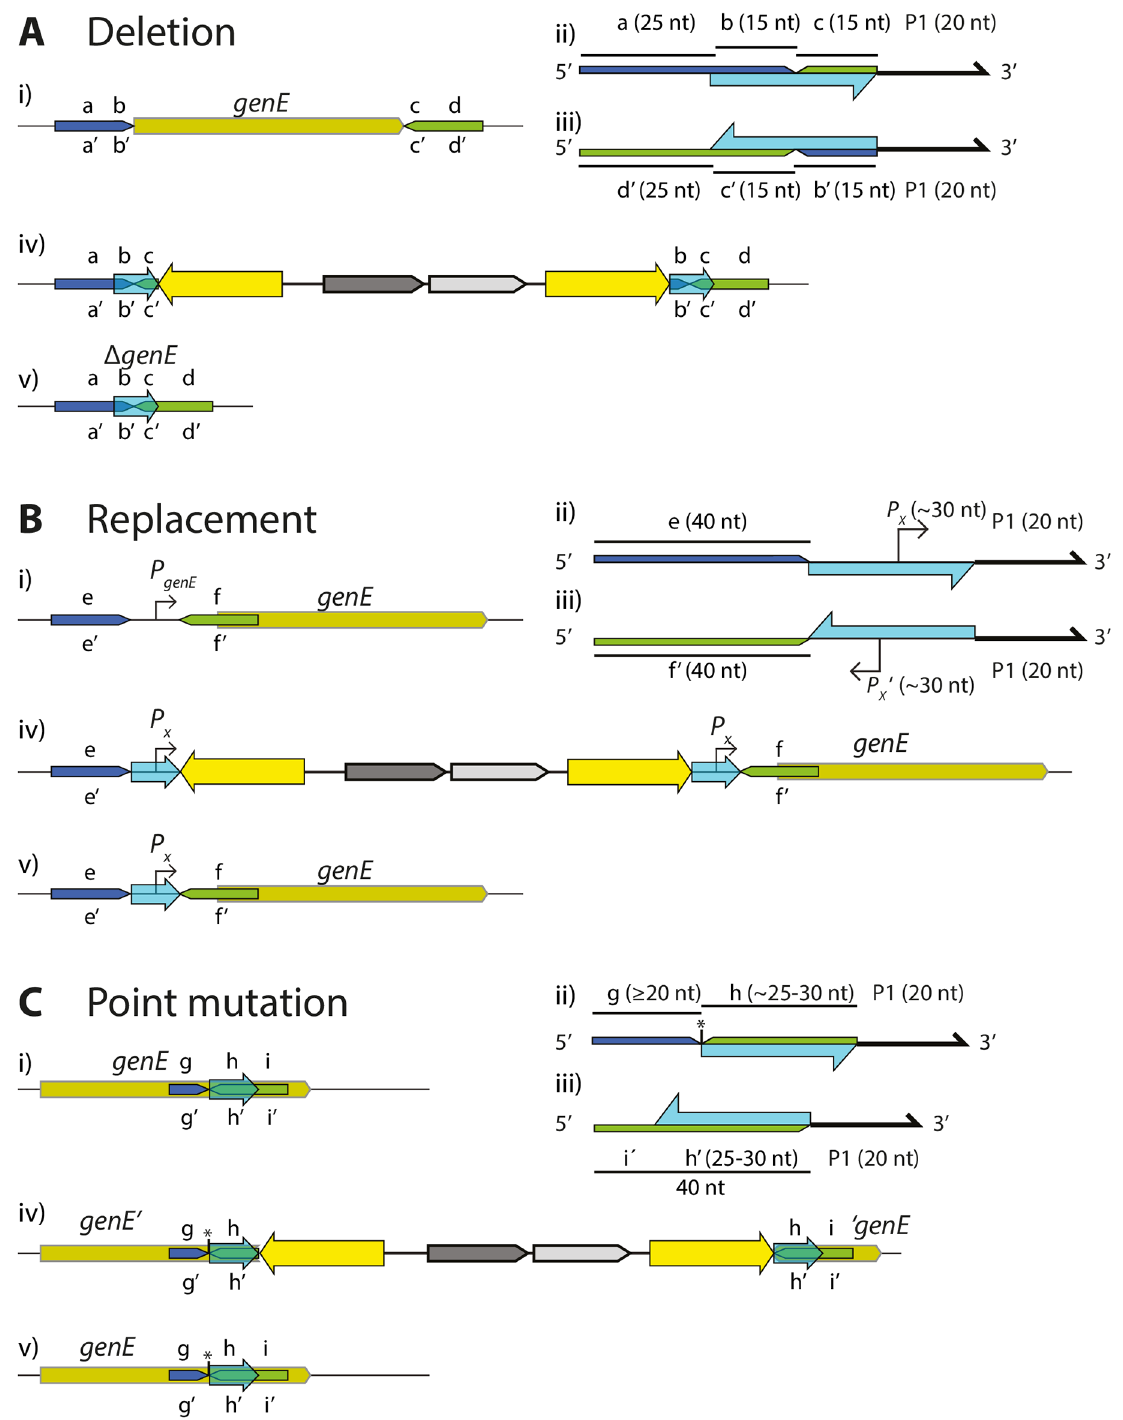
Fig 3. Primer design for DIRex. Light blue arrows indicatethe location and orientation of DR sequencesbetweenwhich recombination is expectedto occur. Sequence segments on the upper strand are labeledwith lower case letters a–i, and on the lower strand the complementary sequencesare labeleda’–i’. (A) Using DIRex for deletinga gene. (A, i) Two 40 nt regionsof recombineeringhomology(a-b, dark blue; c-d, green) are chosen on either side of the sequenceto delete. (A, ii) The “left” oligo (upper strand) is designed with a 40 nt homologyextension(composedof segment a–b) followedby 15 nts from the other side of the sequenceto delete(segment c), and a 20 nt 3’ primer (P1). (A, iii) The “right” oligo (lower strand) is designedwith a 40 nt